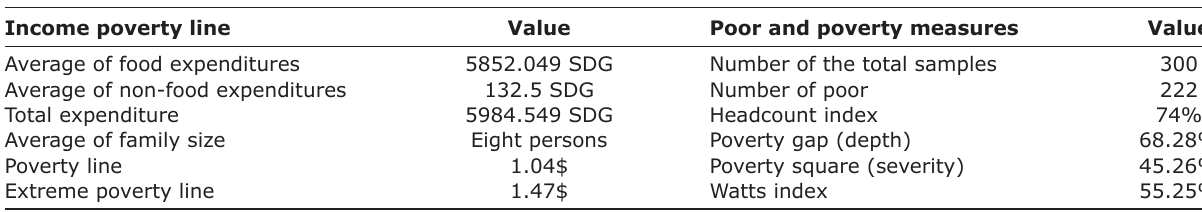
Table-2: Urban poverty measurements in Bahri region.